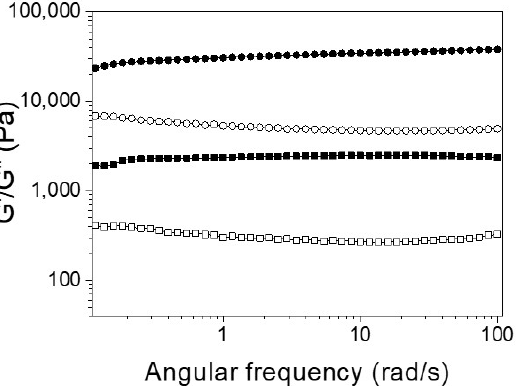
Figure 3. Frequency-dependent ( ω = 0.1–100 rad·s − 1 ) rheological measurement of Ben-IKVAV (circle) and PFB-IKVAV (square) at a concentration of 1 wt.% under pH 7.4 (solid for G ′ and open for G ′′ ).